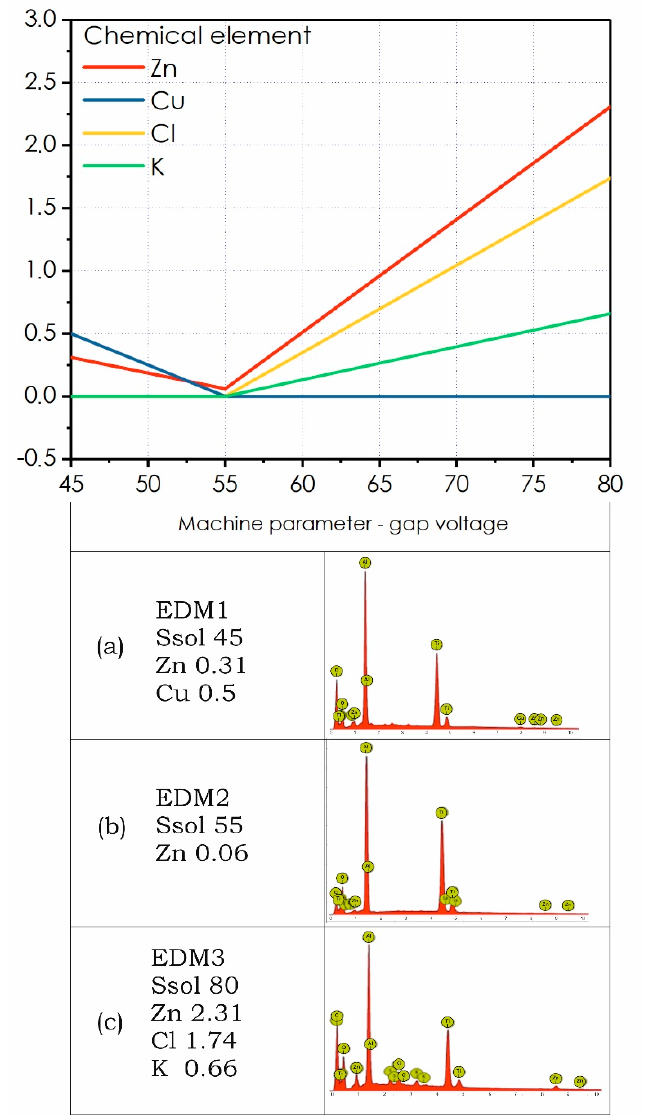
Figure 6. Atomic concentration of impurities in the surface layer measured using Phenom ProX: ( a )—EDM1; ( b )—EDM2; ( c )—EDM3.